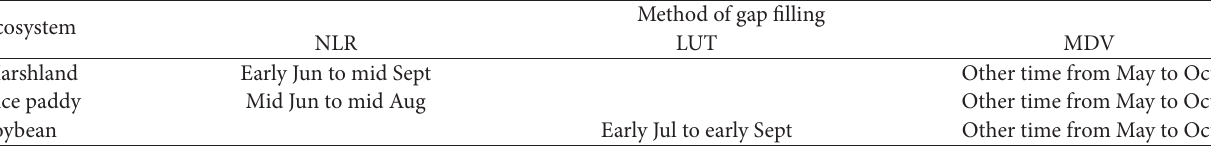
Table 6: Gap filling strategies at short vegetation ecosystems.